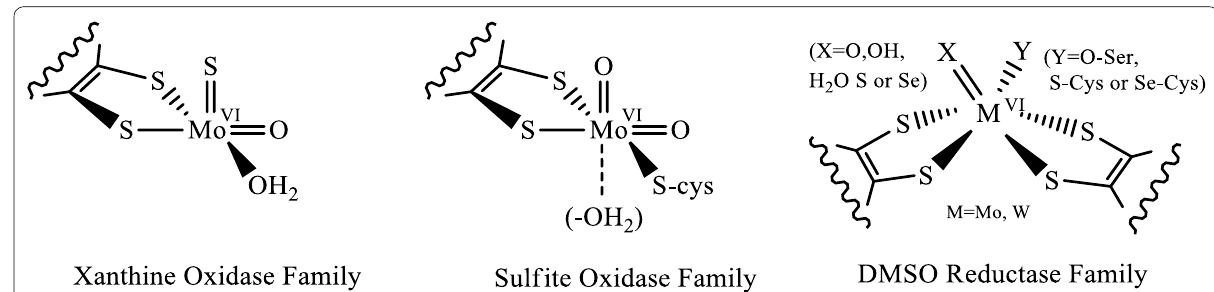
Fig. 1 Active site composition of subfamilies of mononuclear Mo/W